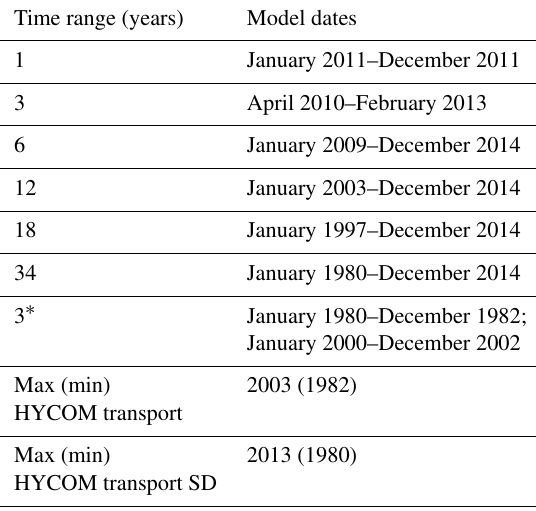
Table 1. Sensitivity experiment time